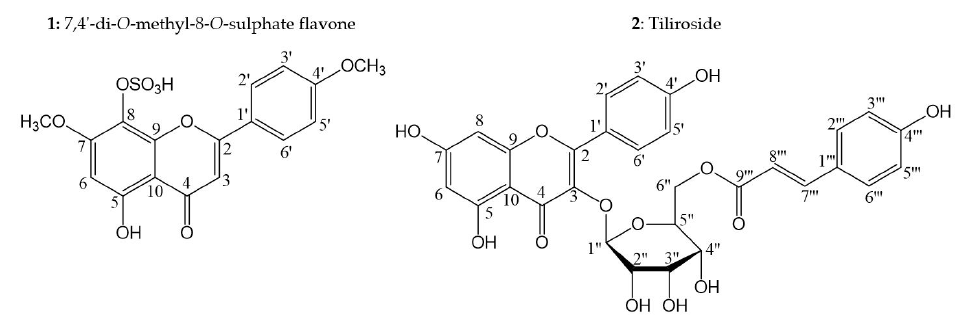
Figure 1. Compounds isolated from aerial parts of Helicteres velutina with potential activity against mosquitoes adult of Aedes aegypti